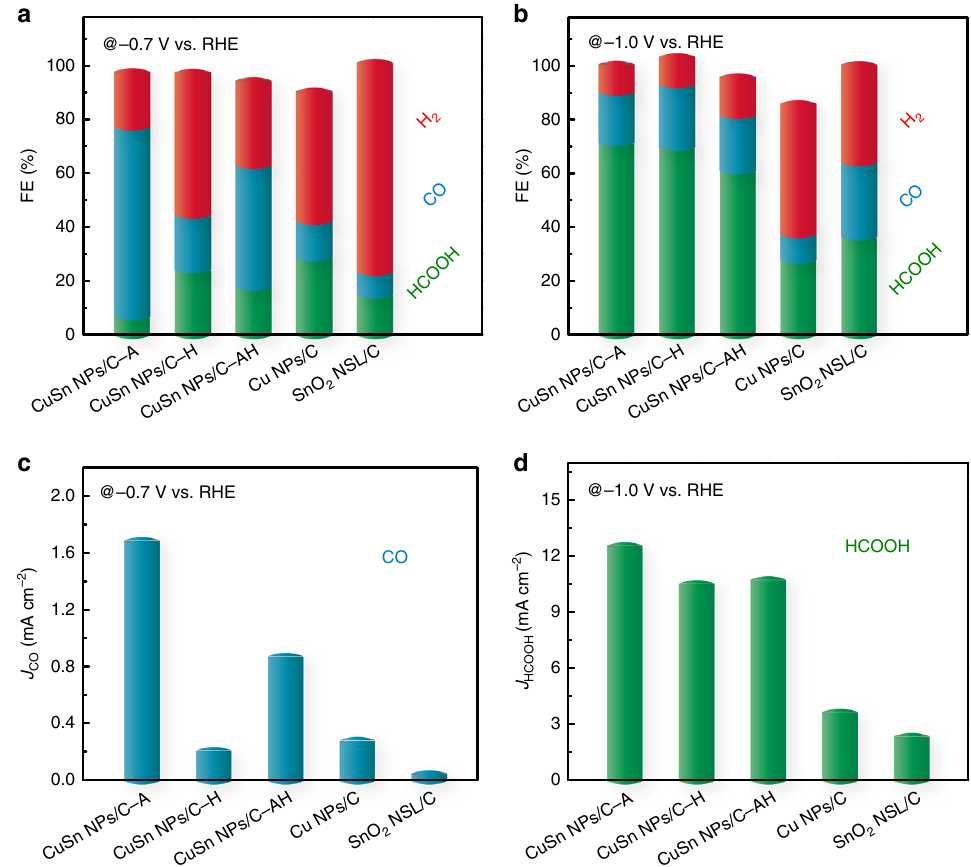
Fig. 4 Comparison of the faradaic ef fi ciencies (FEs) and partial current densities of the electrochemical CO 2 reduction products for various catalysts under speci fi c potential. Histograms of CO, H 2 and HCOOH FEs at a − 0.7 V RHE and b − 1.0 V RHE for different catalysts. Histograms of current densities of c CO at − 0.7 V − 1.0 V RHE and d HCOOH at RHE for different